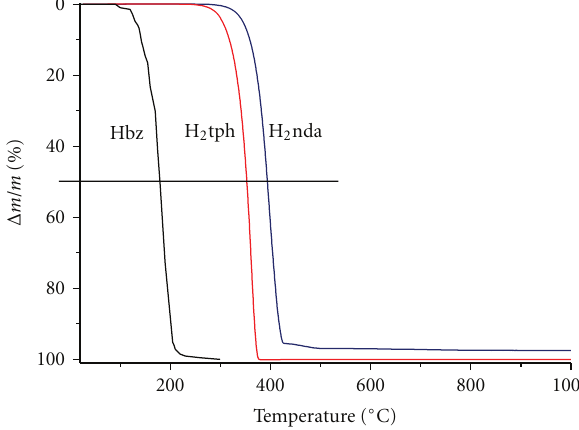
Figure 8: TG curves of Hbz, H 2 tph, and H 2